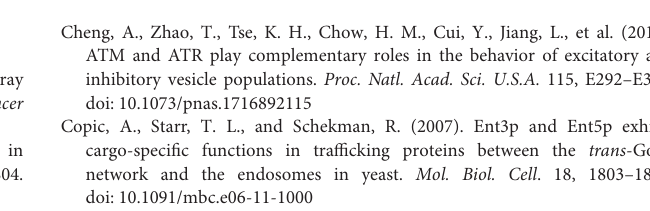
Figure S3 | The localization patterns of clathrin and the indicated cargo adaptors in HeLa cells. HeLa cells were transfected with control siRNA (A,C,E,G,I) or transfected with siRNA against the indicated cargo adaptors (B,D,F,H) or clathrin heavy chain (J) . Day 3 after transfection, cells were analyzed by immunofluorescence utilizing the indicated antibodies. Representative fluorescent images were shown. Scale bar, 10 µ m. (K–M) HeLa cells were mock transfected or transfected with siRNA against AP1 γ 1, clathrin heavy chain or AP3 δ 1. On day 3 after transfection, cells were analyzed by immunoblot (K,L) or RT-PCR (M) . Figure S4 | The localization patterns of clathrin heavy chain on the plasma membrane of COS7 cells after stimulating with epidermal growth factor (EGF). (A) COS7 cells were treated with 5ng/ml EGF for 5min and then stained with antibodies against clathrin heavy chain. Localization patterns of clathrin heavy